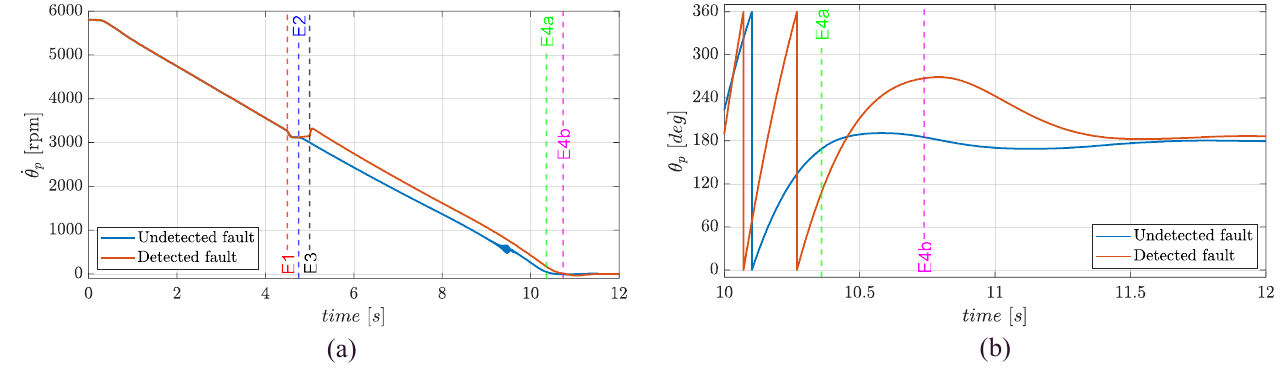
Figure 16. FEPS response in flight termination/landing with phase-to-ground fault on stator 2 (E1, E2, E3 and E4 defined in Section 3.1): propeller speed ( a ), propeller angle ( b ).